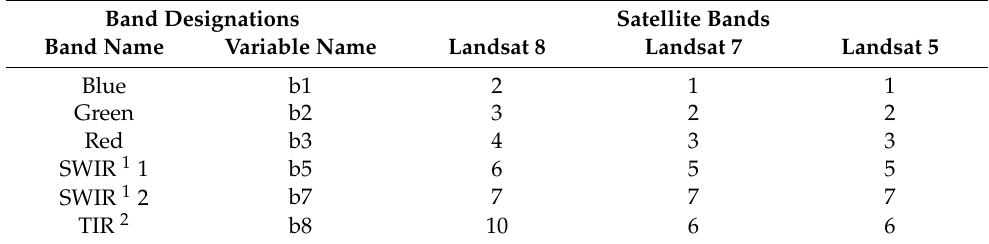
Table 1. Band designations relevant to this study, varying by satellite